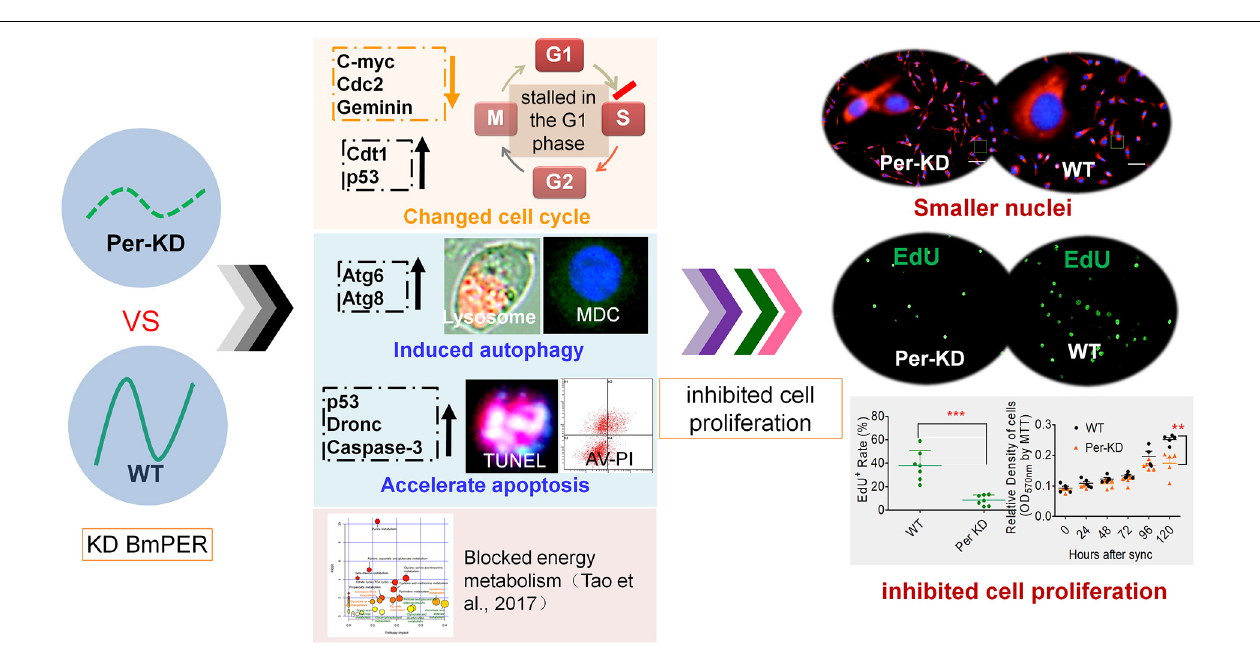
FIGURE 7 | Cell apoptosis induced by BmPer gene knockdown. Apoptosis was assayed in WT and Per-KD cells every 24 h after synchronization. (A) Percentage of single-positive stained TUNEL cells ( n = 12). (B) BmDronc mRNA expression assayed by qRT-PCR. The reference gene was BmRp49 ( n = 3). (C) BmCaspase-3 immunofluorescence staining ( n = 12). (D) Caspase-3 activity ( n = 3). Nuclei were visualized by blue DAPI fluorescence. ∗∗ p < 0.01 and ∗∗∗ p < 0.001.